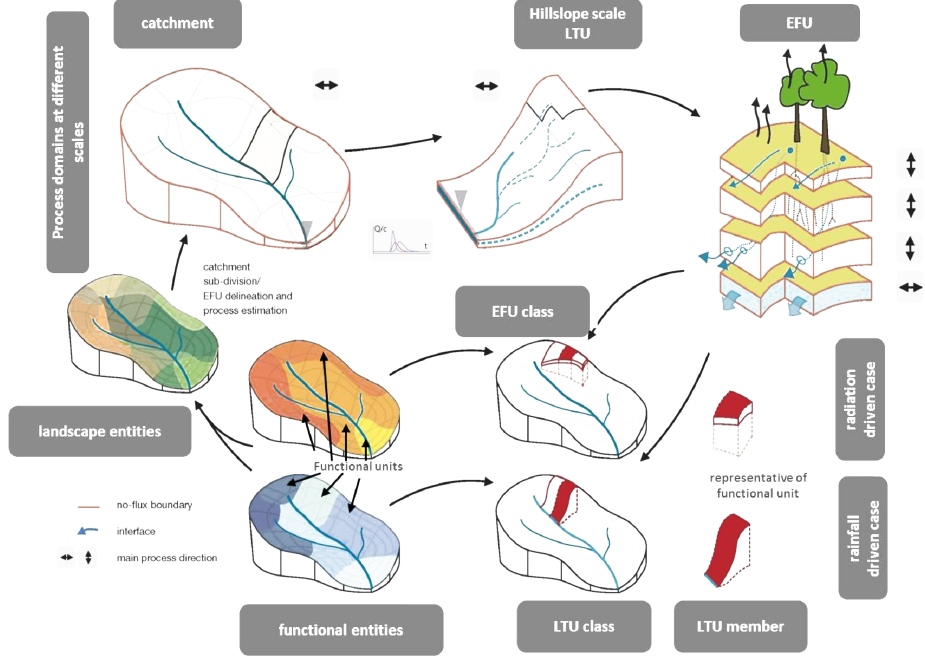
Figure 1. Catchment functioning reflecting context-dependent controls of different elementary functional units (EFUs) or lateral topological units (LTUs). Members of the same EFU class exert similar terrestrial controls on the surface energy balance (when in similar states and exposed to similar radiation/rainfall forcing). EFUs thus control functional similarity during radiation-driven conditions acting in parallel; class members could be ideally represented by the same parameter set related to the energy balance and vertical water flows. Members of the same LTU class exert similar terrestrial controls on rainfall runoff generation as the embedded EFUs are interlinked by lateral, gravity-driven water flows. Hillslope-scale LTUs control functional similarity; members of classes could be ideally represented by the same parameter set characterizing lateral flows and EFU-scale